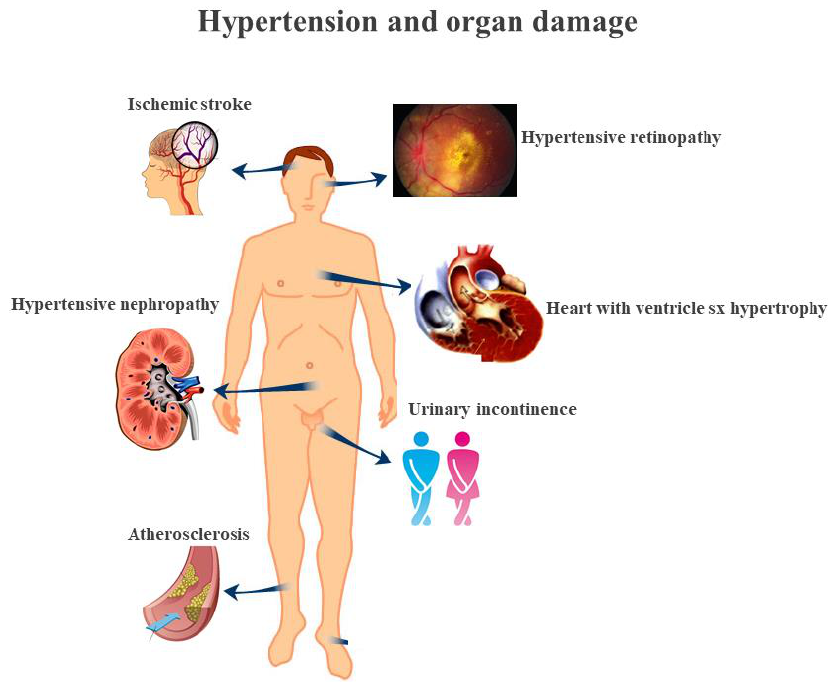
Figure 1. Secondary damage induced by hypertension.